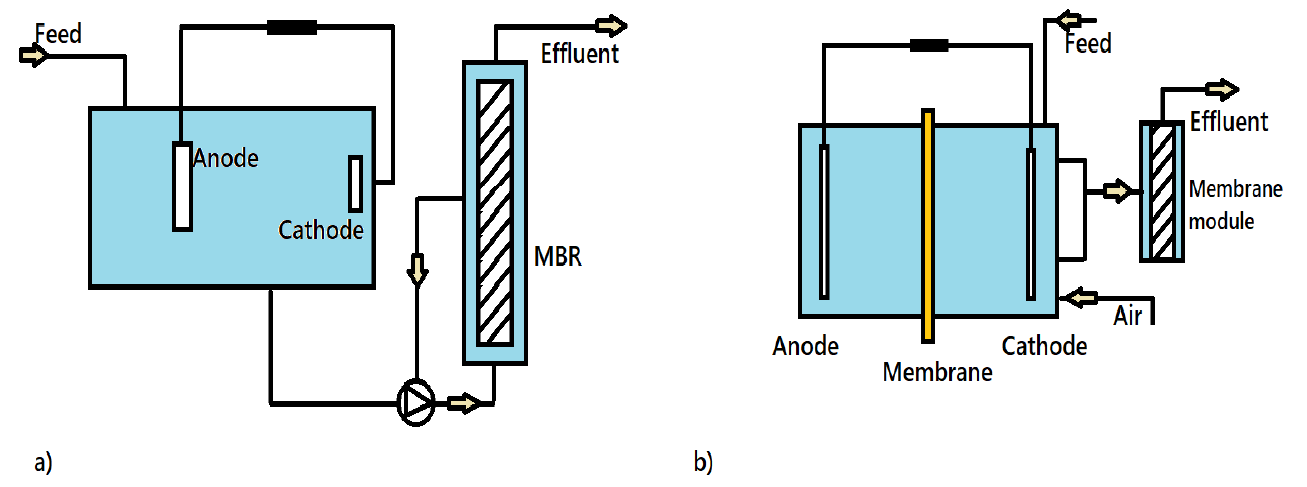
Figure 11. MFC-MBR layouts: ( a ) single chamber, ( b ) dual chamber.